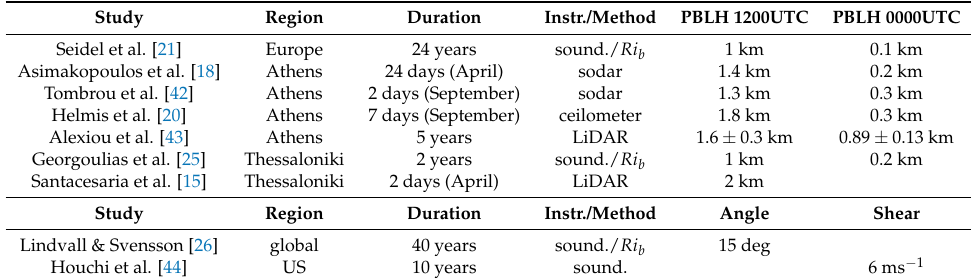
Table 2. Summary of the results of previous relevant studies regarding the PBLH, the wind turning angle and the wind shear. The median values are either the values reported or inferred from Figures and the data in the